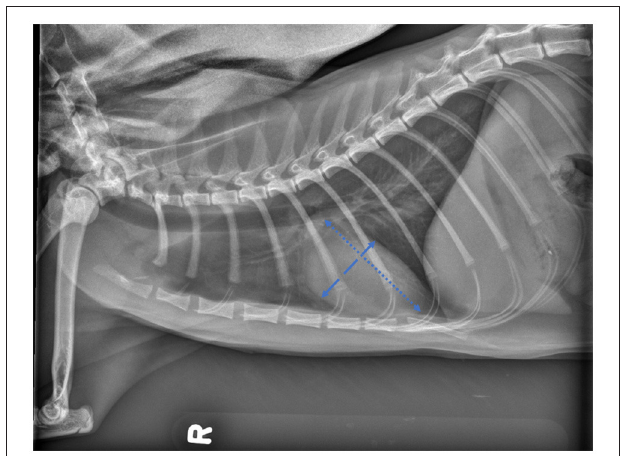
FIGURE 2 | Lateral projection of skeletally mature feline patient demonstrating the cardiac landmarks for vertebral heart scale (VHS) measurements as described by Buchanan.